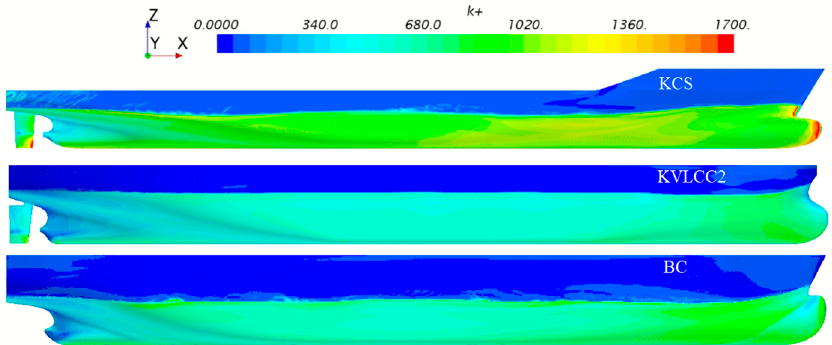
Figure 15. The obtained k + distributions for R1 fouling condition along the KCS ( upper ), KVLCC2 ( middle ) and BC ( lower ) hull.